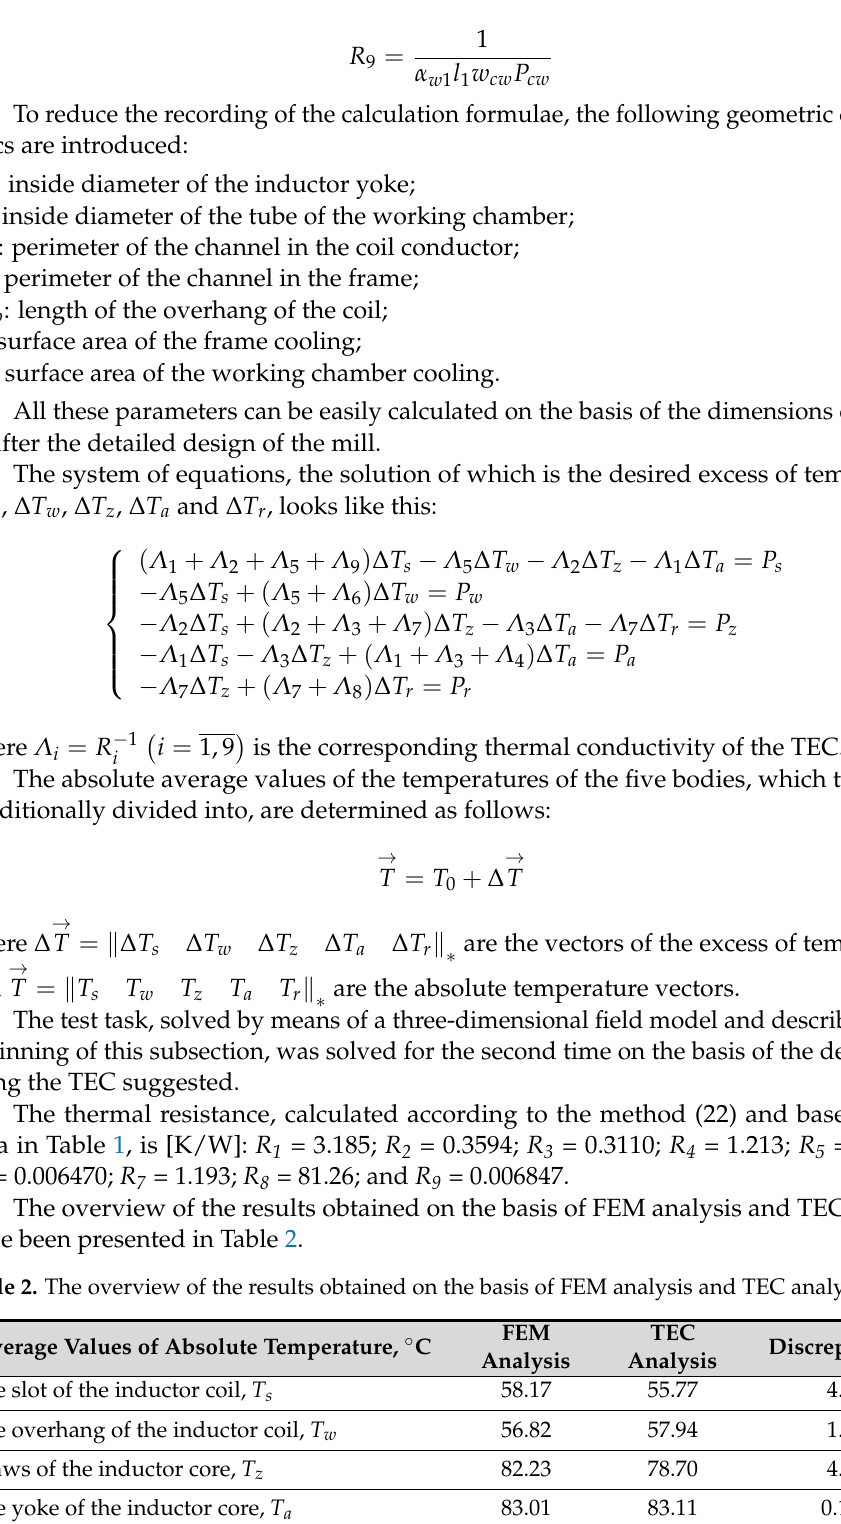
FEM TEC Discrepancy, Analysis Analysis